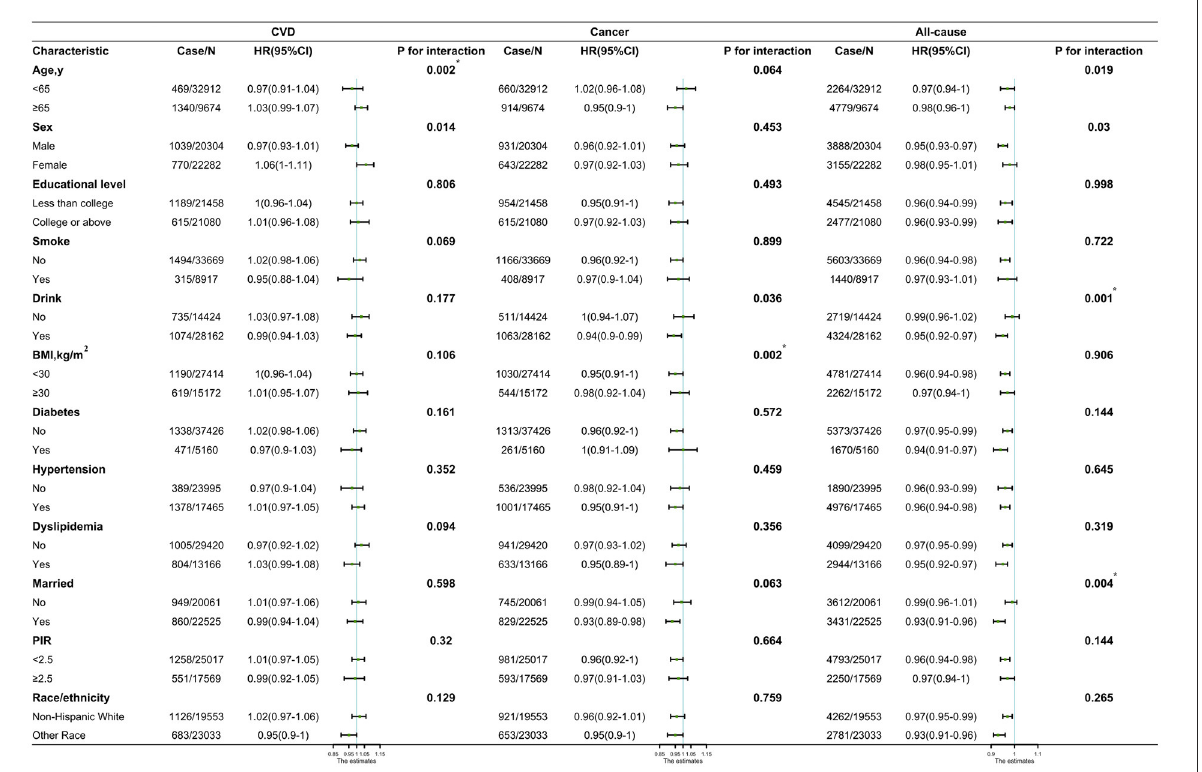
FIGURE3 Hazard ratios (HRs) of CVD, cancer, and all-cause mortality per quintile increase in resistant starch intake by subgroups and sensitivity analyses. CVD, cardiovascular disease; HR, hazard ratio; CI, confidence interval; BMI, body mass index. *Being significant after Bonferroni correction.